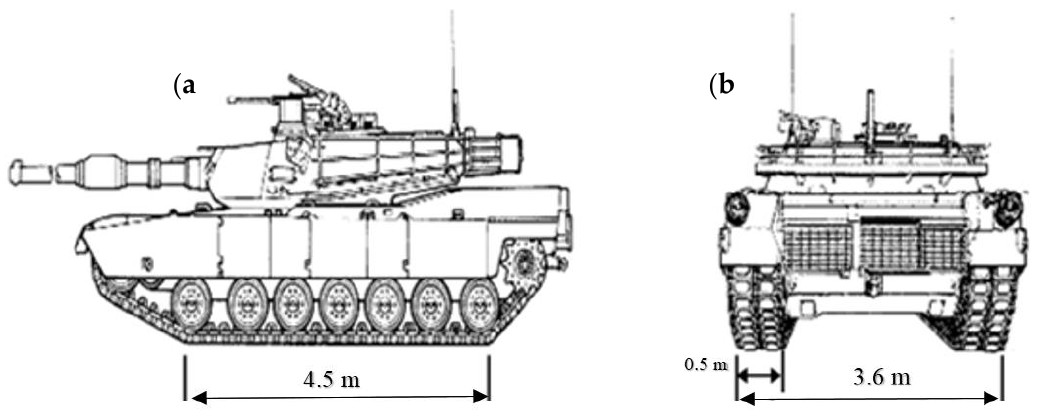
Figure 6. The tank dimensions. ( a ) Side view of MLC70, ( b ) Elevation of MLC70.